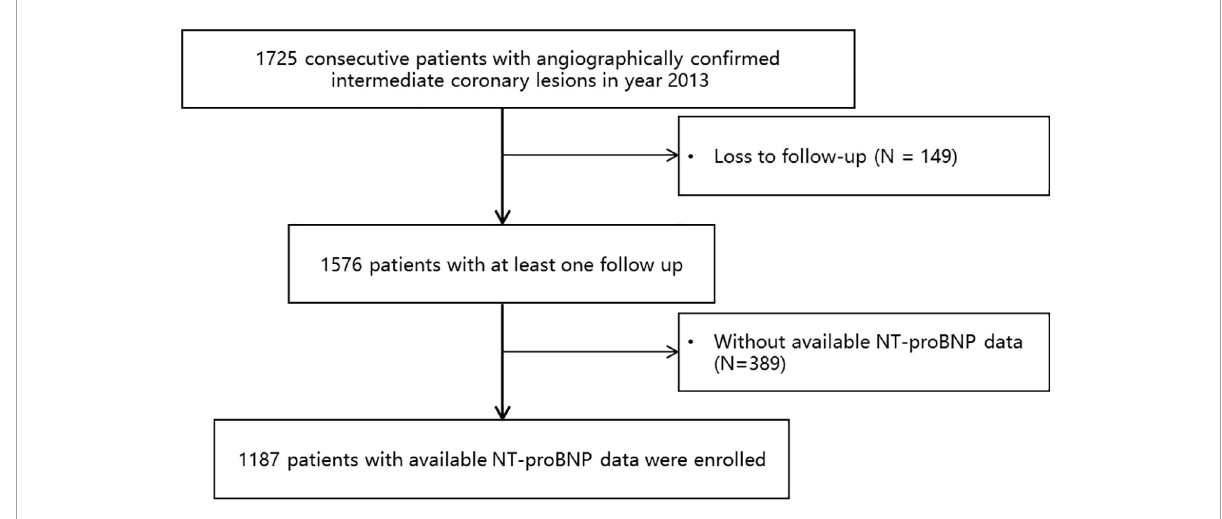
FIGURE1 A study flowchart. A total of 1,725 consecutive patients who underwent coronary angiography in the Fuwai hospital in the year 2013 with angiographically confirmed intermediate coronary lesions were enrolled. Patients loss to follow-up or with unavailable N-terminal pro-brain natriuretic peptide (NT-proBNP) data were excluded. A total of 1,187 patients were finally included in the current